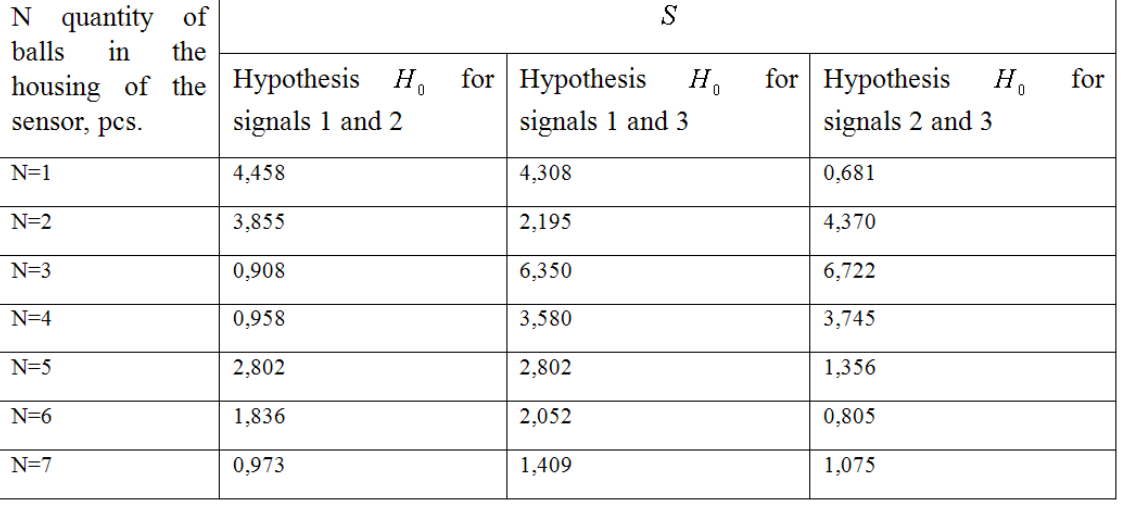
Statistics for check of a hypothesis of uniformity of